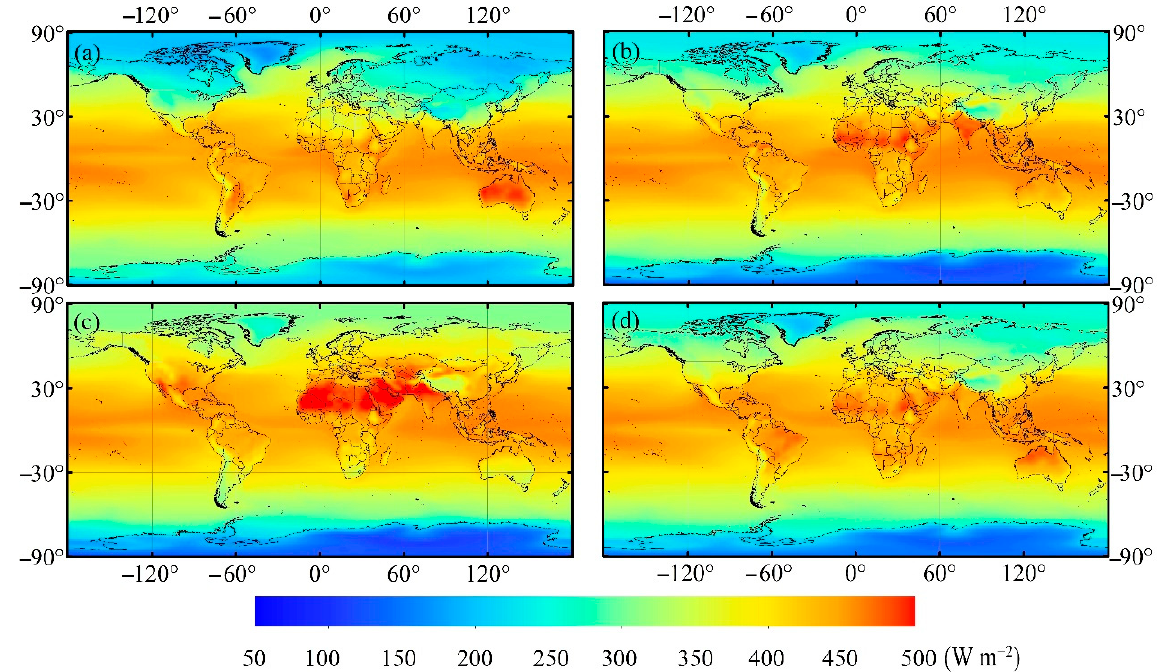
Figure 7. Spatial variations in the SULR estimations from the CMIP6 GCMs using the BMA method in the DJF (December, January, and February) ( a ), MAM (March, April, and May) ( b ), JJA (June, July, and August) ( c ), and SON (September, October, and November) seasons ( d ) from 2000 to 2005 (in units of W m − 2 ).